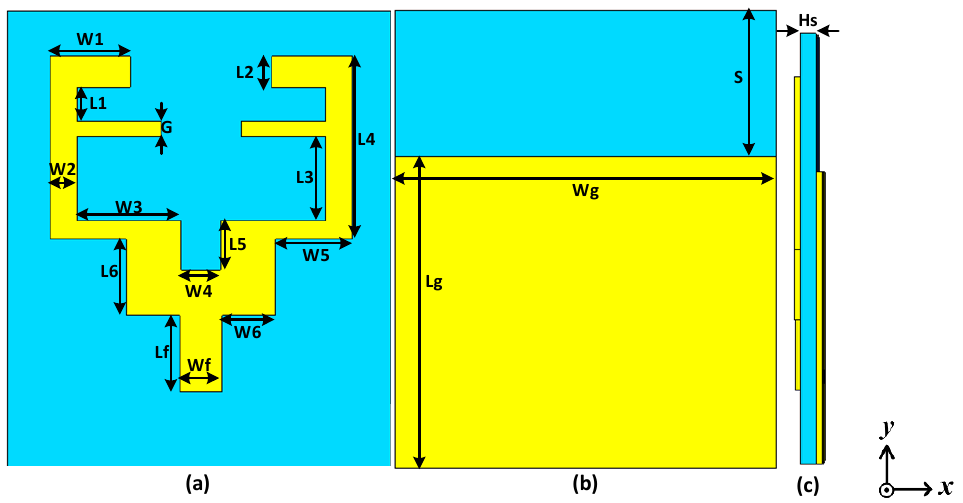
Figure 1. Structure of proposed triband antenna: ( a ) front view, ( b ) back view, and ( c ) side view.